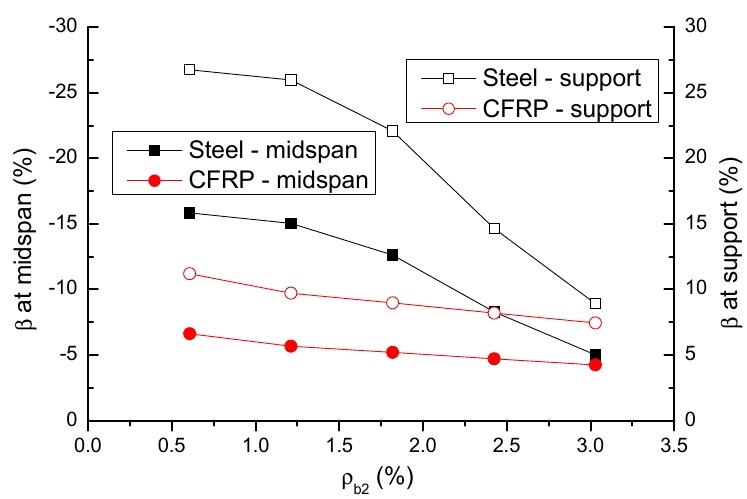
Figure 14. Variation of moment redistribution at ultimate with varying bar ratio.